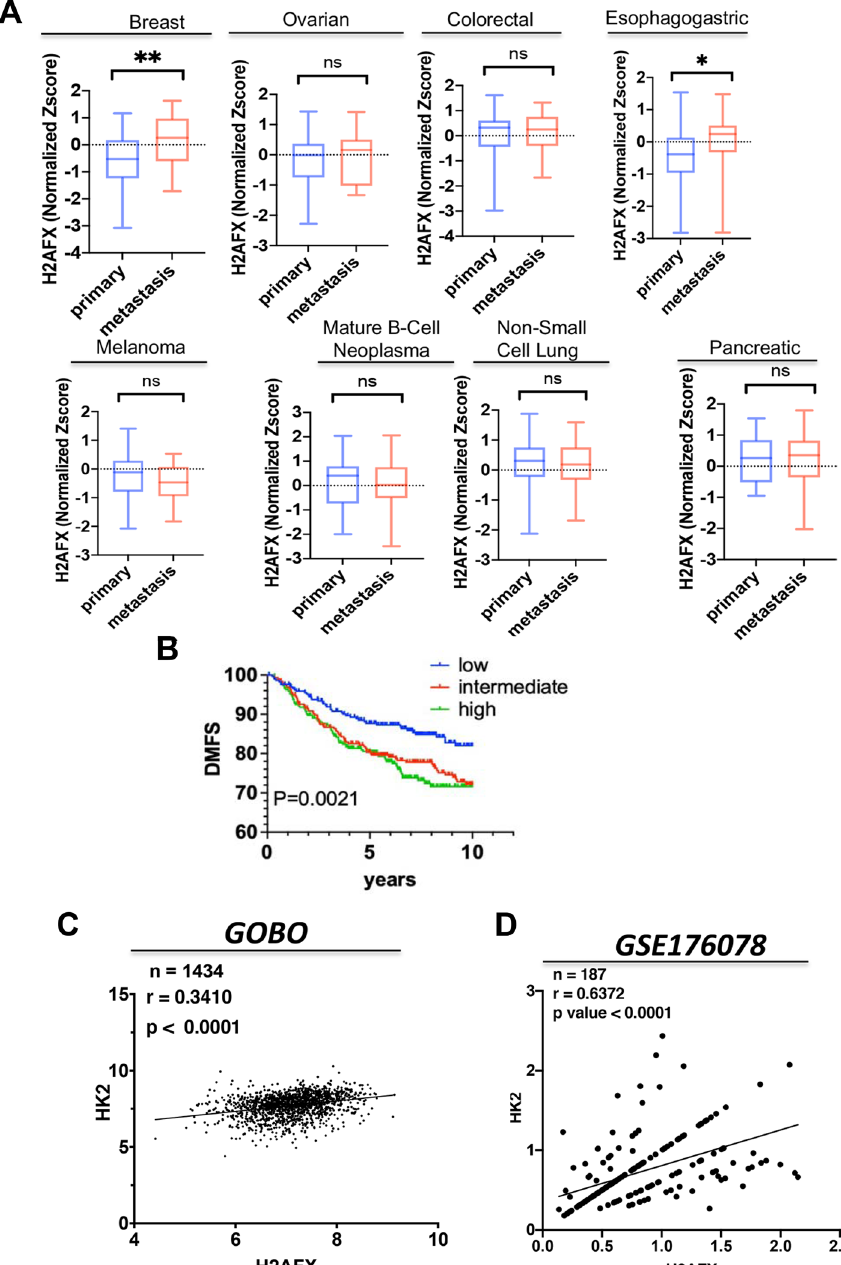
Figure 5. H2AX expression is correlated with that of HK2 and with survival rate in patients with invasive breast cancer. ( A ) Dataset from Cancer Cell line Encyclopedia (CCLE) was utilized to assess level of H2AX transcript comparing cells derived from primary sites with the ones from metastatic sites. CCLE normalized expression data and clinical information were downloaded from cBioportal. Breast (n = 29 primary vs. n = 26 metastasis), colorectal (n = 48 primary vs. n = 11 metastasis), esophagogastric (n = 66 primary vs. n = 27 metastasis), mature B-cell neoplasms (n = 39 primary vs. n = 15 metastasis), melanoma (n = 31 primary vs. n = 25 metastasis), non-small cell lung (n = 75 primary vs. n = 50 metastasis), ovarian (n = 34 primary vs. n = 15 metastasis), pancreatic (n = 26 primary vs. n = 15 metastasis), and small cell lung (n = 18 primary vs. n = 32 metastasis). For breast, **p value = 0.0092; for esophagogastric, *p value = 0.0284; ns, non-significant. ( B ) Breast cancer microarray raw data and clinical information from GOBO (see “Methods” section) were downloaded. Chin raw data was downloaded from EMBL-EBI . To assess distant metastasis-free survival (DMFS), all specimens were evenly divided into three groups to generate a Kaplan–Meier survival curve using in-house Python script. H2AX expression level was clustered based on the following distribution: low (H2AFX = 4.419–6.69, n = 296 samples; intermediate (H2AFX = 6.694–7.267, n = 296 samples, and high (H2AFX = 7.267 – 9.14, n = 295). ( C ) Expression level of H2AFX and HK2 were extracted from the GOBO datasets described in ( B ) including samples without published medical history, and the analysis was performed using Spearman correlation coefficient. ( D ) Similar analysis was conducted using single-cell RNAseq dataset from GSE176078 and specimens of triple-negative breast cancer (TNBC) were specifically considered for the analysis using Seurat library in R (n = cell